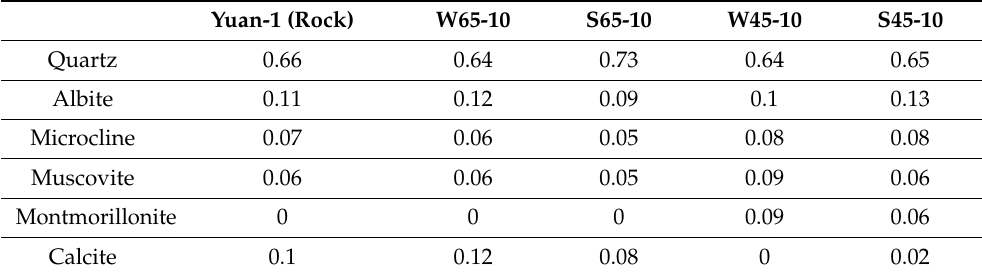
Table 5. Mineral composition in core rock before and after water–rock interaction (in %).